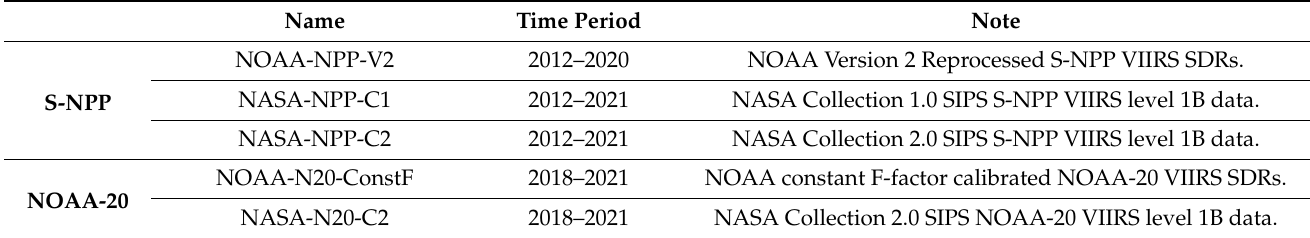
Table 2. S-NPP and NOAA-20 VIIRS RSB SDRs evaluated in this